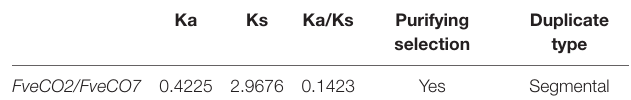
TABLE 2 | Ka/Ks analysis for the duplicated FveCO paralogs. Ka Ks Ka/Ks Purifying Duplicate selection